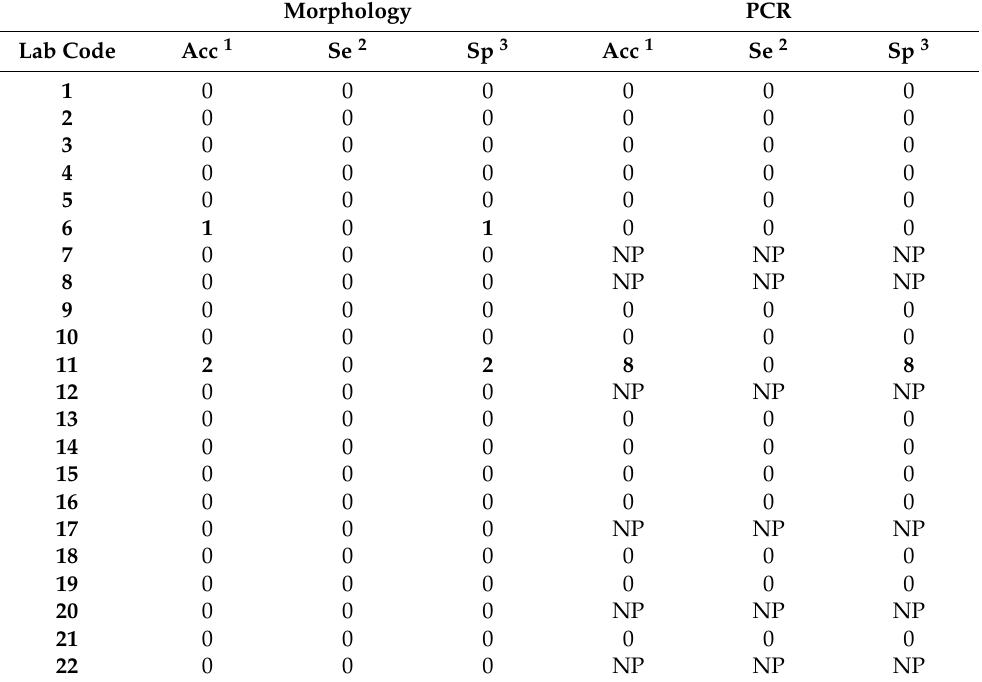
scores (i.e., “warning signal” or “action signal”) are highlighted in